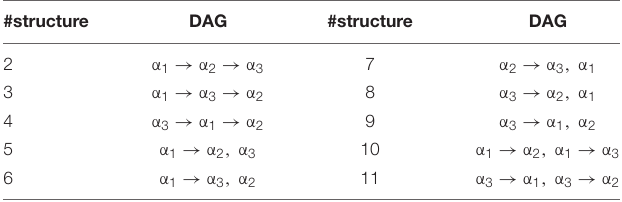
TABLE 10 | Summary of hierarchical attribute structures.